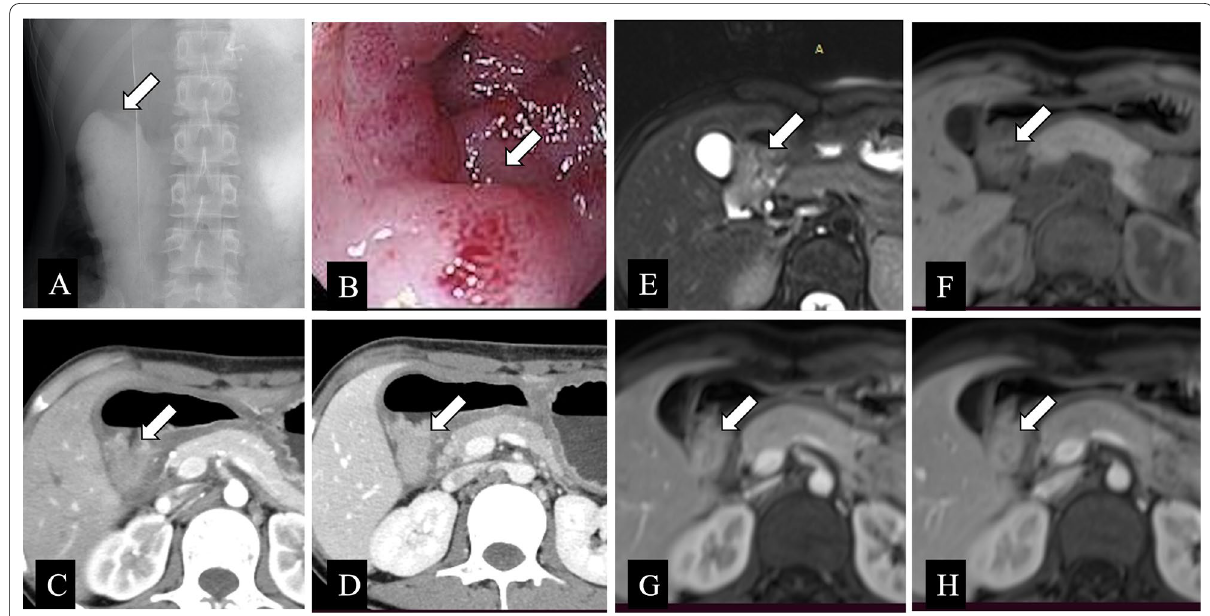
Fig. 4 A 15‑year‑old female presented with abdominal pain and distension underwent various imaging examinations. a Single spot image of the upper gastrointestinal tract on a barium fluoroscopic study demonstrated an intraluminal filling defect within the duodenum with a central indentation (white arrow) consistent with heterotopic pancreas. b Endoscopy showed a subepithelial lesion (white arrow) along the first portion of the duodenum with surrounding duodenitis. c–d Contrast‑enhanced axial CT images revealed a hyper‑enhanced lesion (white arrows) with ill‑defined margin and thickening of the surrounding duodenal wall. e–h Non‑contrast axial T2‑weighted ( e ), pre‑contrast T1‑weighted ( f ), post‑contrast arterial T1‑weighted ( g ), and post‑contrast venous T1‑weighted images ( h ) showed a lesion within the first portion of the duodenum (white arrows) demonstrating T2‑weighted slightly hyperintense signal, pre‑contrast T1‑weighted slightly hypointense signal, and post‑contrast T1‑weighted isointense like those of the normal